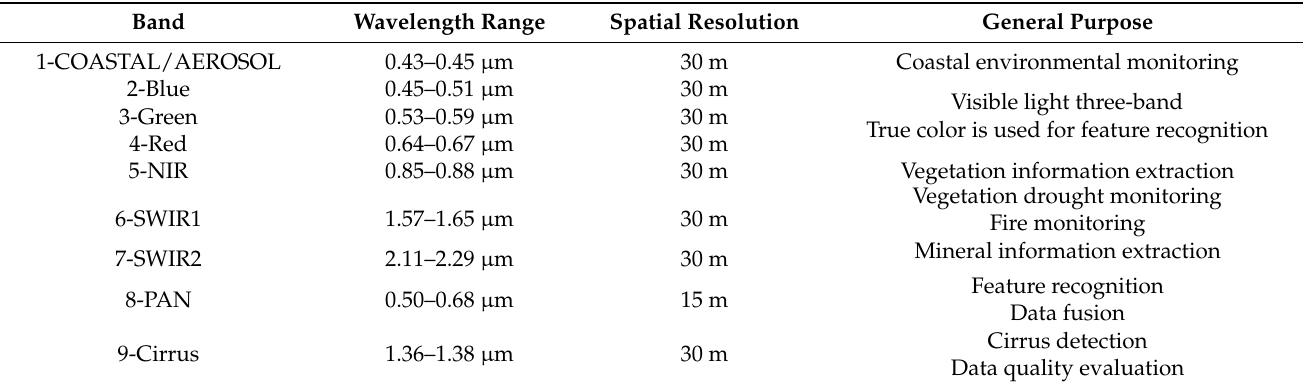
Table 1. Landsat 8 OLI sensor parameter.